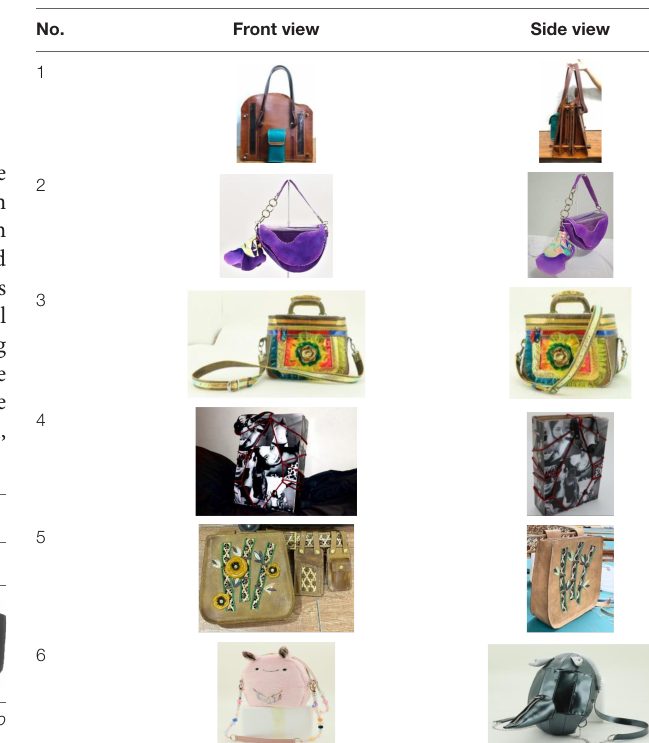
TABLE 5 | Examples of the